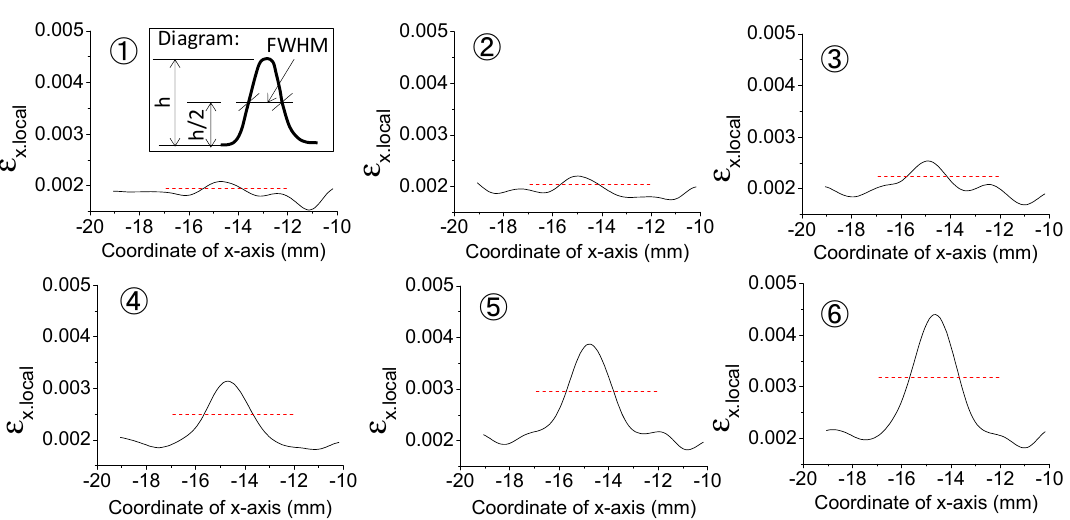
Figure 9. Local strain distribution along the CD line in Figure 5. The dashed line represents half of the peak value. ① to ⑥ correspond, respectively, to each image in Figure 5.